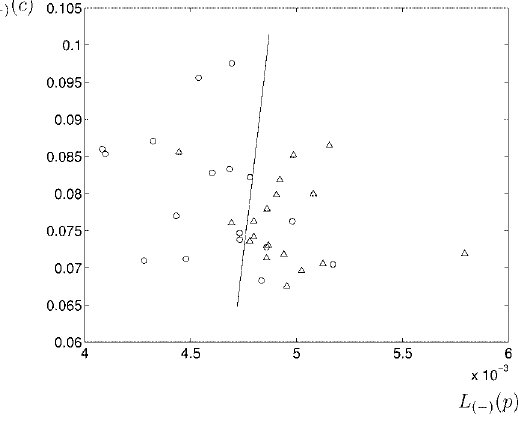
Fig. 9. The mean value of the adaptive lacunarity feature L ( + ) ( c ) is plotted versus the 10 percentile of the feature L ( − ) ( p ) for samples from the good prognosis ( ◦ ) and bad prognosis ( ∆ ) classes. The de- cision boundary for the classifier computed from the whole data set is also indicated. The nuclei are from histological